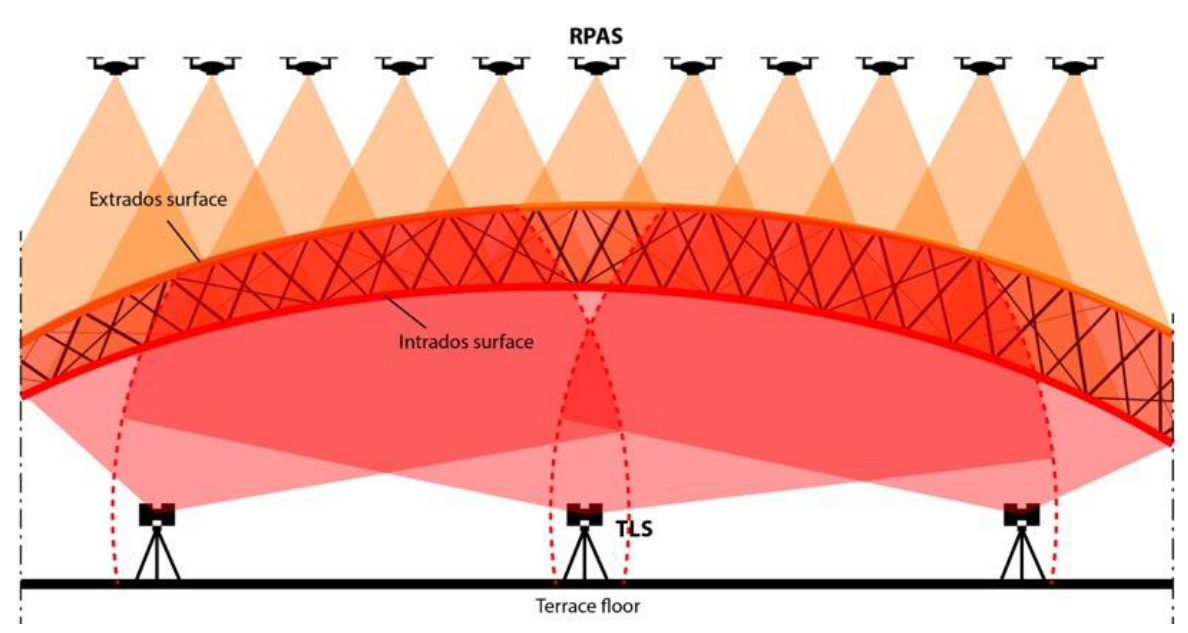
Figure 7. Integration between the active (for intrados) and passive (for extrados) survey techniques. The schema highlights the variable GSD and the filtering sphere (dashed red circle) imposed in range-based data cleaning (fixed at a 30 m of radius).